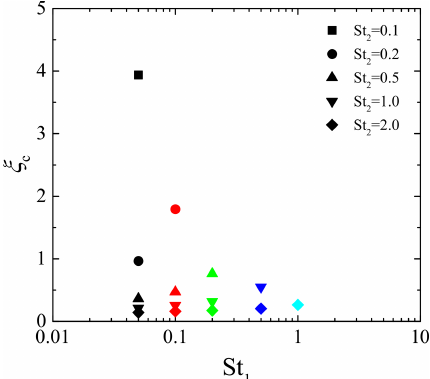
Figure 4. Critical wave number ξ c for a combination of Stokes num- bers, St 1 and St 2 . The symbol color and type indicate the com- bination of Stokes numbers. The black, red, green, blue, and light blue symbols are St 1 = 0 . 05, 0.1, 0.2, 0.5, and 1.0, respectively. The square, circle, triangle, inverse triangle, and diamond symbols are St 2 = 0 . 1, 0.2, 0.5, 1.0, and